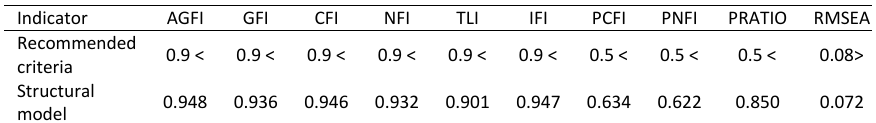
Table 3: Model fitness indices Table 3. Model fitness indices